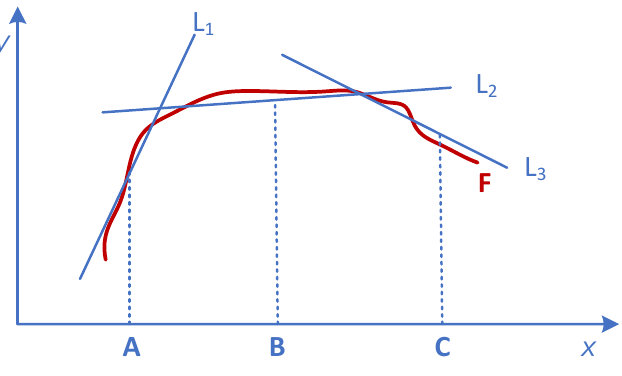
Figure 2. Illustration of active lines.